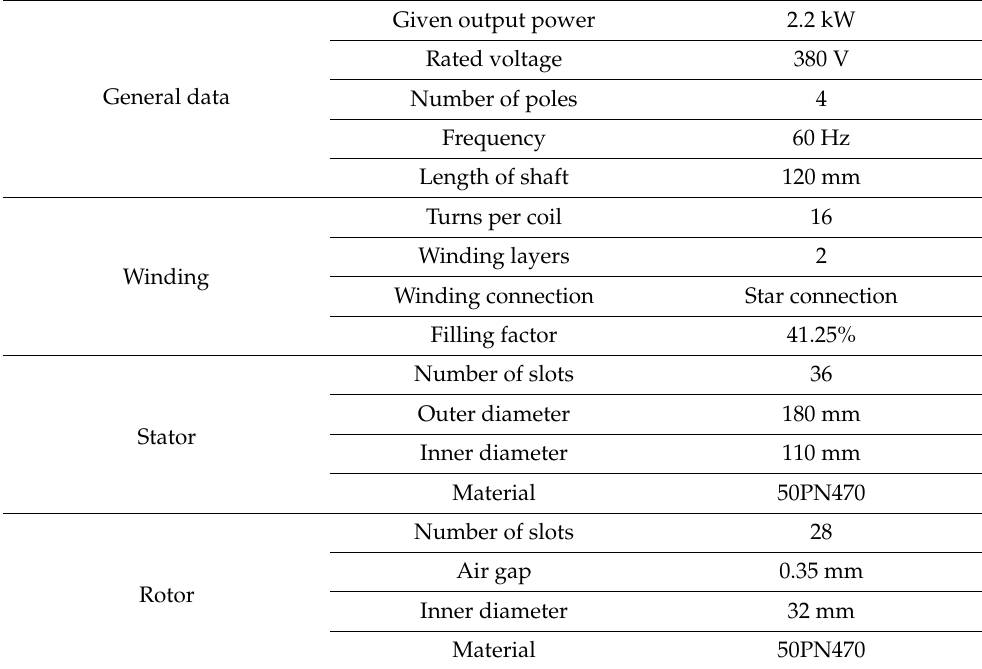
Table 1. Specifications of the three-phase squirrel cage induction